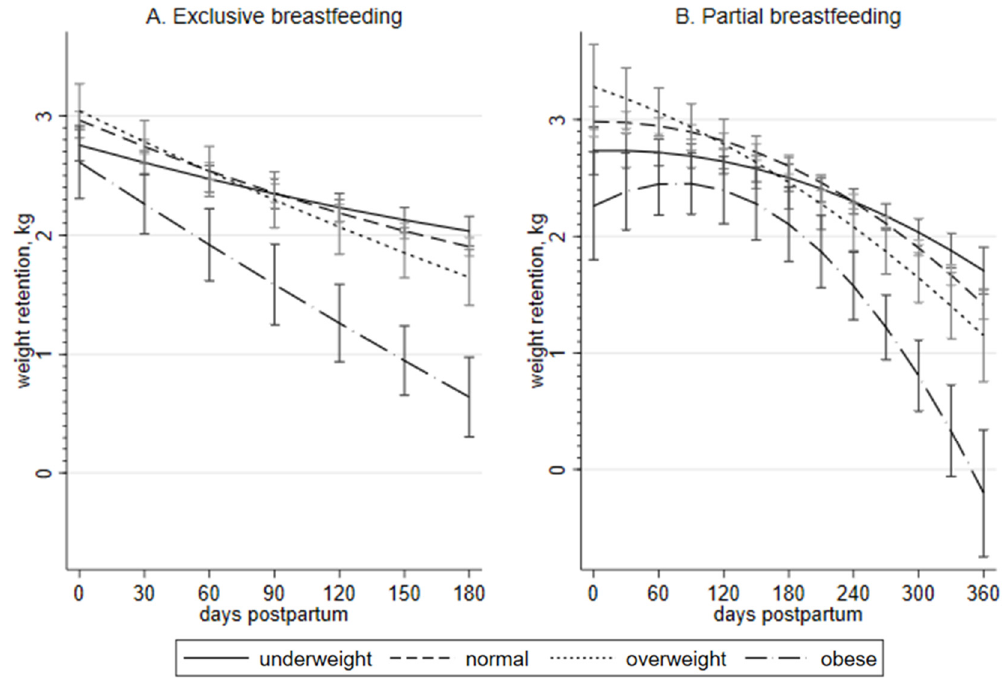
Figure 3. Postpartum weight retention and duration of breastfeeding in Taiwanese women by pre-pregnancy BMI ( N = 52,367): ( A ). exclusive breastfeeding; ( B ). partial breastfeeding. Notes: (1) postpartum weight retention was assessed at 7–14 months postpartum; (2) X-axis represents duration of breastfeeding in days postpartum; (3) each time point on the same curve represents different women due to the cross-sectional design of the study; (4) sample sizes for each time point are available in the supplementary materials (Tables S2 and S3); (5) weight status was categorized by BMI cutoffs for Taiwanese population—18.5, 24, and 27 kg/m 2 (Taiwan Health Promotion Administration. (2018). BMI classification (in Chinese). Retrieved from http://health99.hpa.gov.tw/OnlinkHealth/Onlink_BMI.aspx).